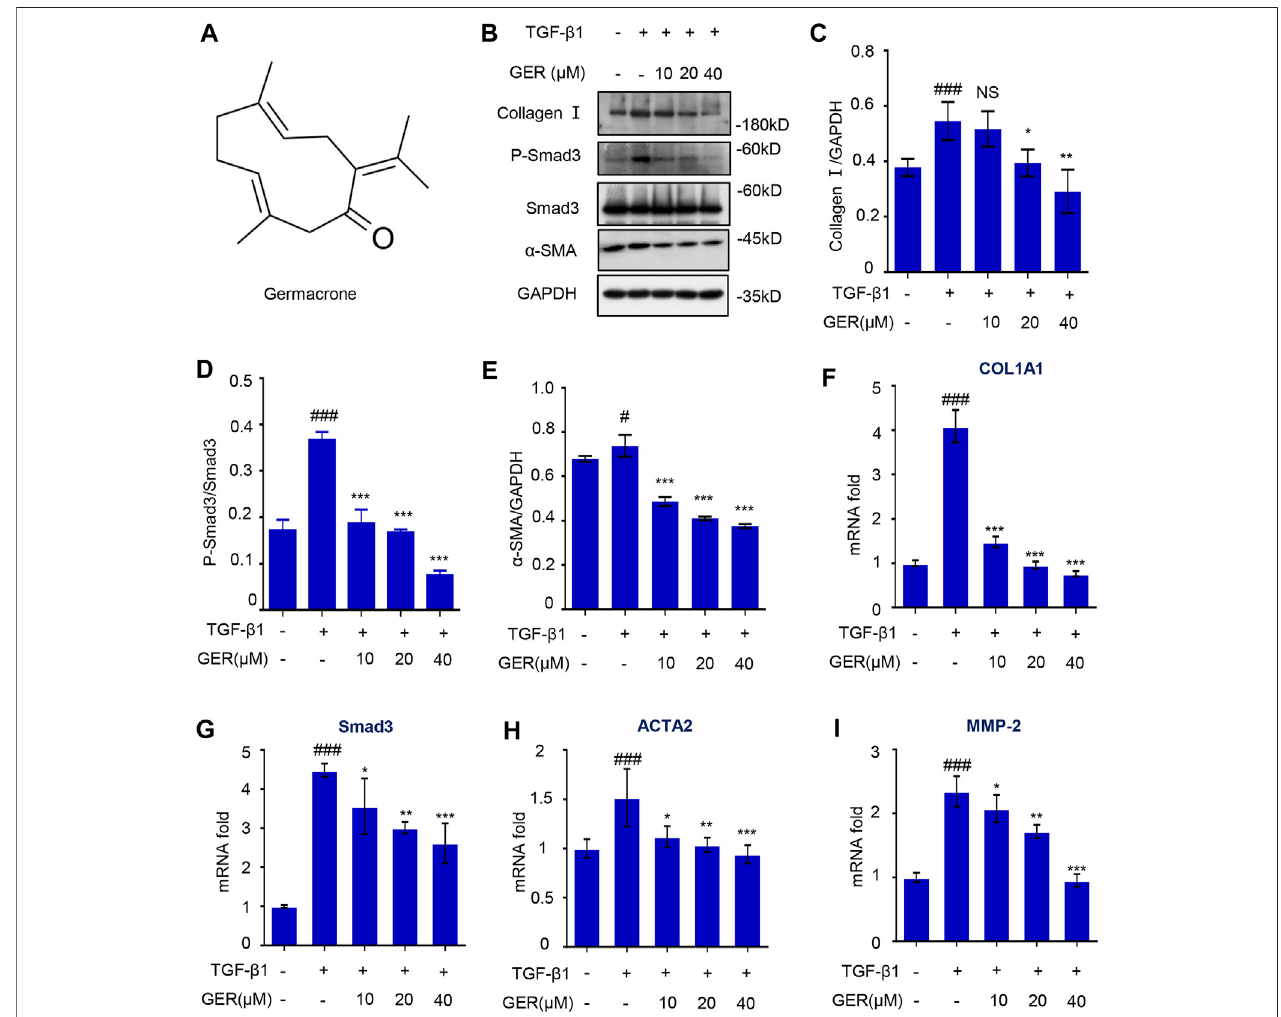
FIGURE 2 | GER suppresses TGF- β induced HSCs activation by inhibiting TGF- β /Smad signaling pathway. (A) The molecular structure of GER. (B) Western blot for collagen I, P-Smad3, Smad3, α -SMA protein level in LX-2, and GAPDH was used to as the loading control. (C – E) Quantitative analysis of collagen I, P-Smad3, Smad3, α -SMA, and GAPDHexpression ( n (cid:2) 3). (F-I) Quantitative real-time PCR analysisofCOL1A1,Smad3, ACTA2,and MMP-2 mRNA expression inLX-2. The ΔΔ C t method was used to quantify relative changes ( n (cid:2) 3). All data are presented as means ± SEM. # p < 0.05, ### p < 0.001 vs. the control group. * p < 0.05, ** p < 0.01, *** p < 0.001 vs. the TGF- β group. NS, non-signi fi cant vs. the TGF- β